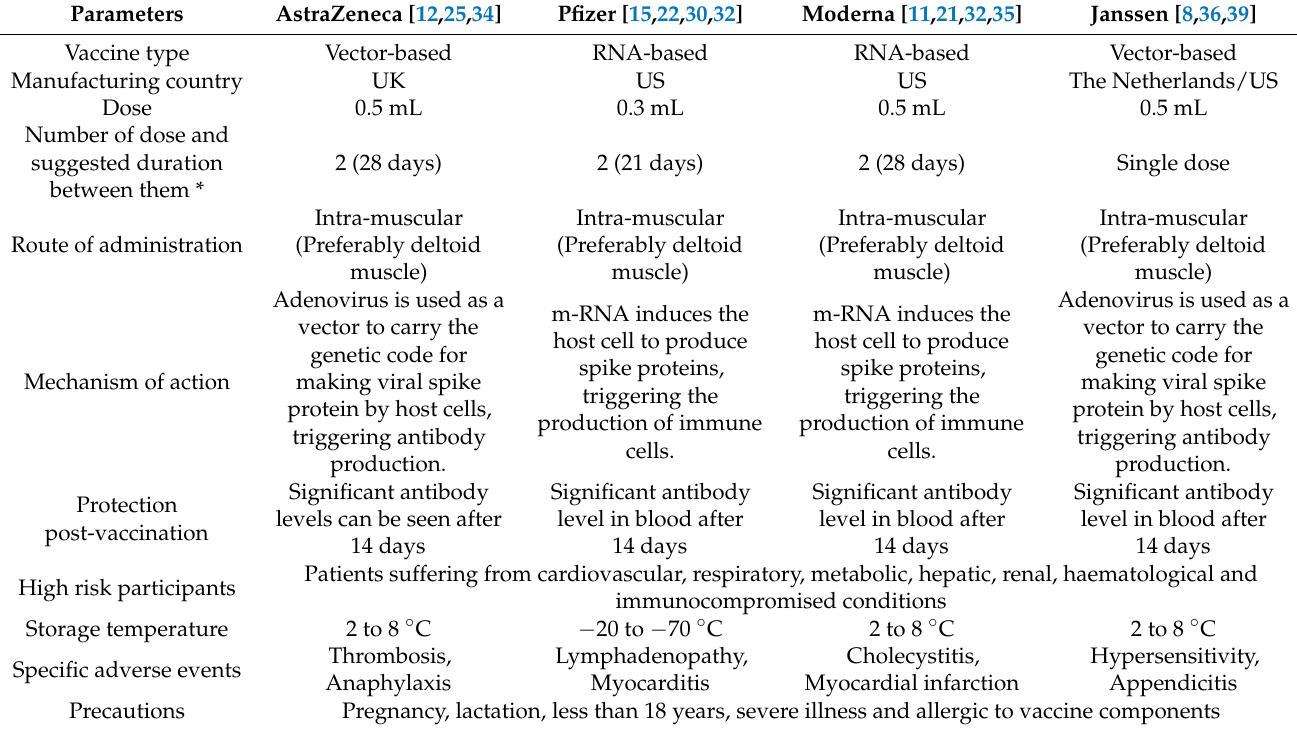
Table 1. Descriptive information on the four approved COVID-19